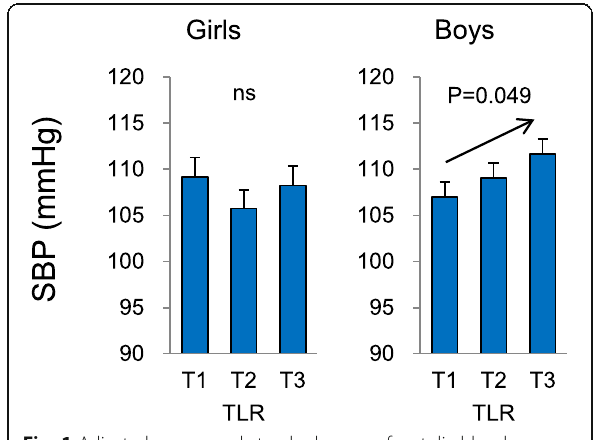
Fig. 1 Adjusted means and standard errors of systolic blood pressure (SBP) at follow-up for tertiles (T1, T2, and T3) of trunk-to-leg fat ratio (TLR). Mean values were calculated from the general linear model after adjusting for confounding factors, including the age, height, pubic hair appearance, whole body fat, and SBP at baseline. Arrows show a significant trend of SBP from T1 to T3. For trend tests of SBP, multiple linear regression analysis was performed. The dependent variable was SBP at follow-up, and independent variables were tertiles of TLR, age, height, pubic hair appearance, whole body fat, and SBP at